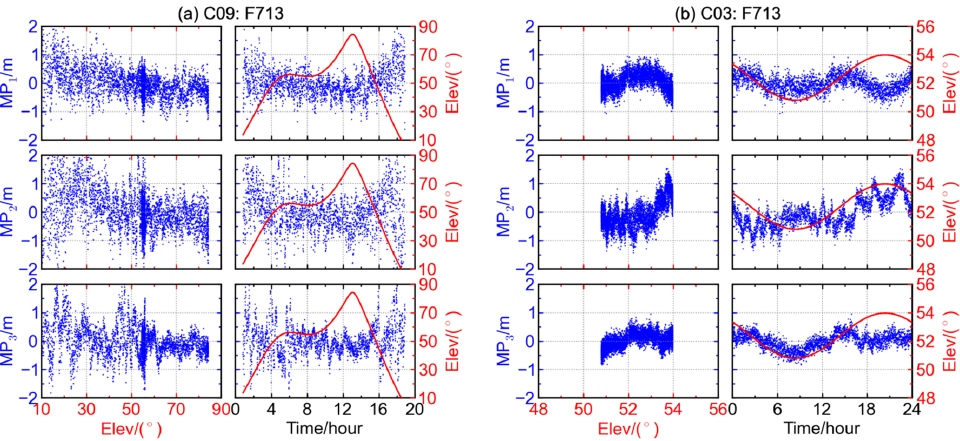
Figure 4. The relationship between multipath combination (blue) and satellite elevations (red) for BDS ( a ) IGSO satellite C09 and ( b ) GEO satellite C03 at station F713.